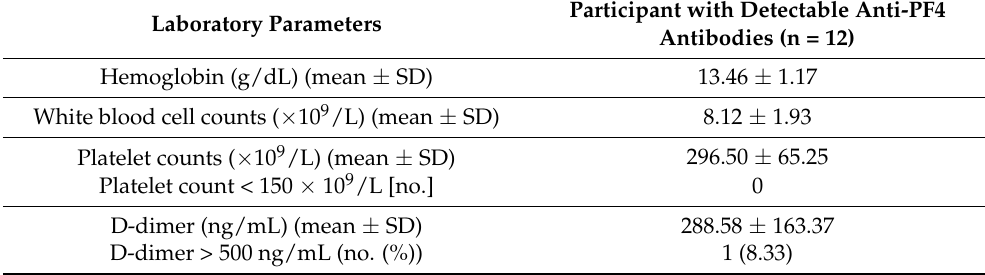
Table 3. Laboratory results of participants with detectable anti-PF4